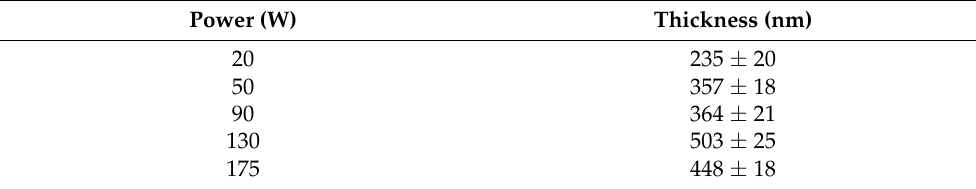
Table 1. Thickness of continuous PPOLs; the values were collected at different condition of power (W) in the continuous regime. For each plasma coating, three samples were prepared; the values of the thickness are the average of three